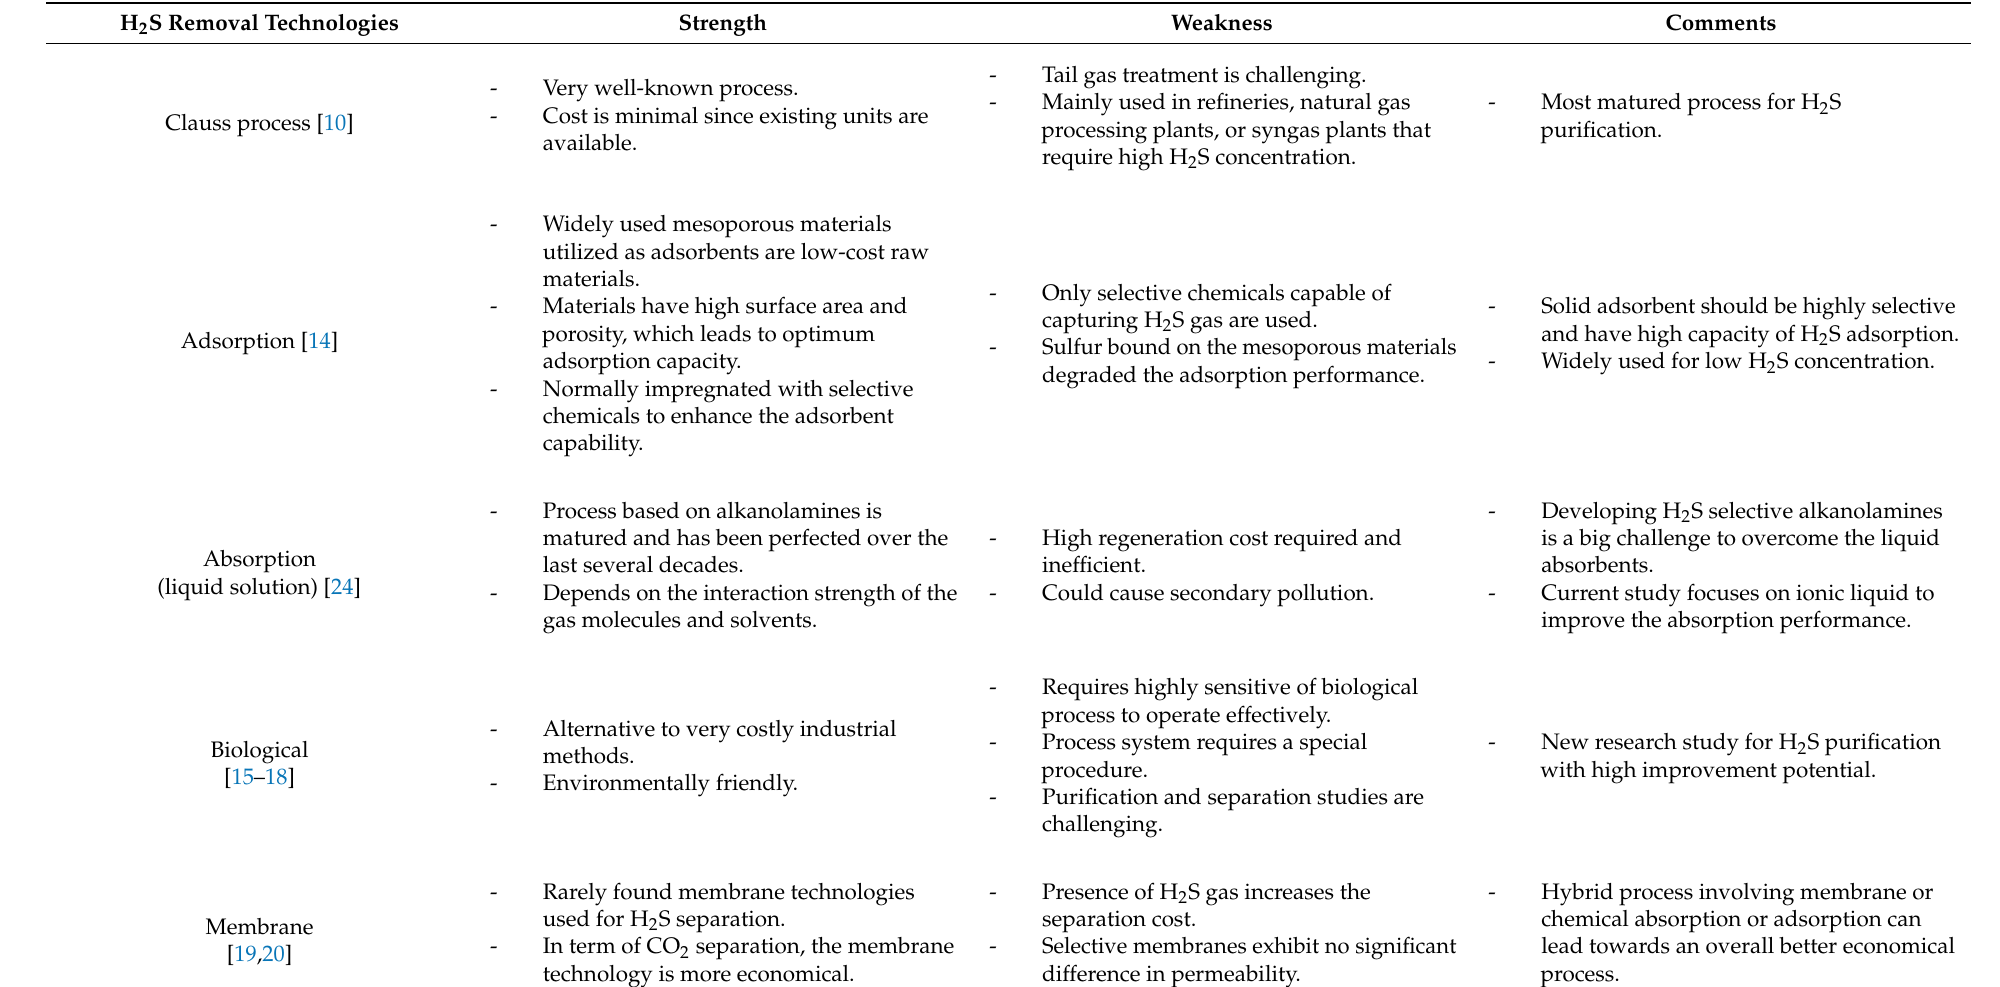
Table 1. Summary of different H 2 S removal